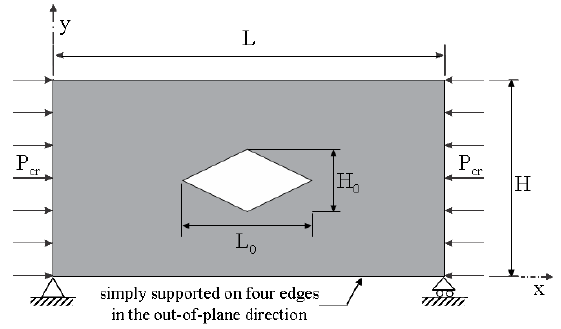
Figure 5. Plate with centered diamond